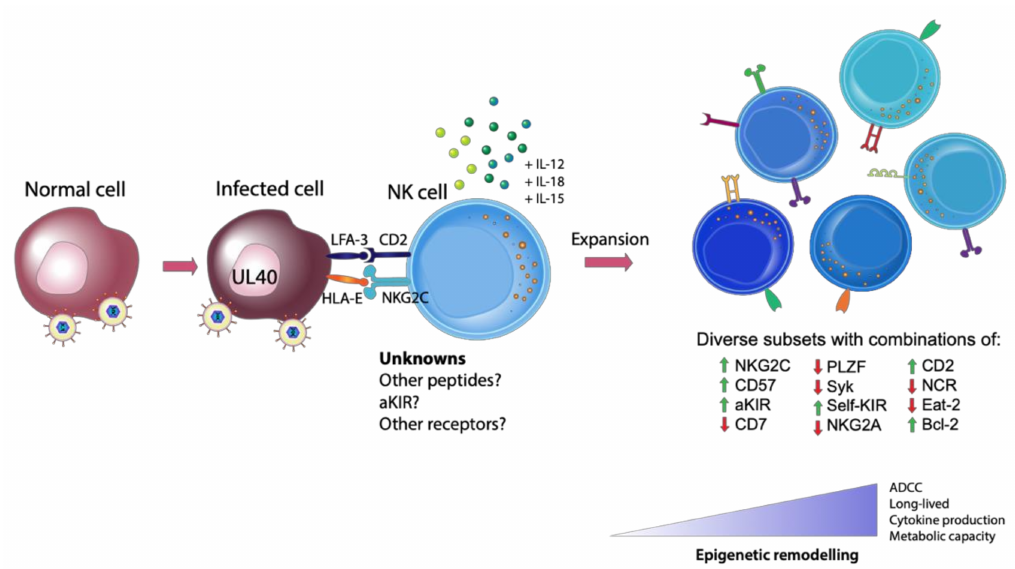
Figure 1. Generation of Adaptive natural killer (NK) cells. The expansion of adaptive NK cells requires three signals: (1) appropriate receptor engagement in the context of a viral peptide (such as HLA-E and NKG2C, with other unknown viral or self-peptides and receptors likely involved), (2) co-stimulation and (3) proinflammatory cytokines. This engagement with a virally infected cell leads to the generation of diverse, highly functional subsets of NK cells with di ff ering degrees of epigenetic